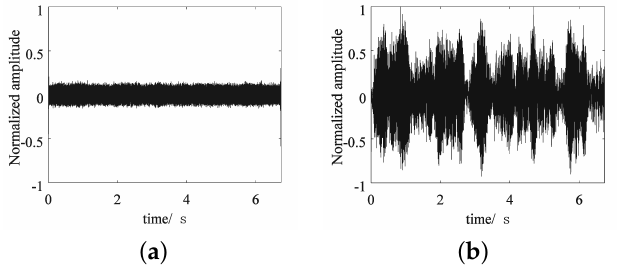
Figure 13. The separation results for signal C when different K values are set: ( a ) K = 3; ( b ) K = 4.